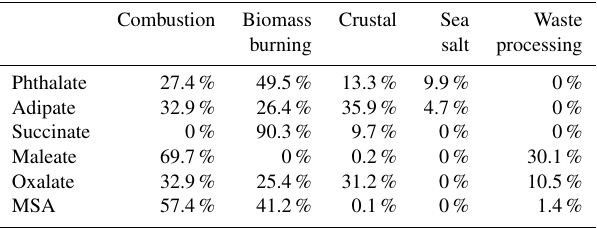
Table 2. Contributions of the five positive matrix factorization (PMF) source factors to each individual organic acid and MSA. Combustion